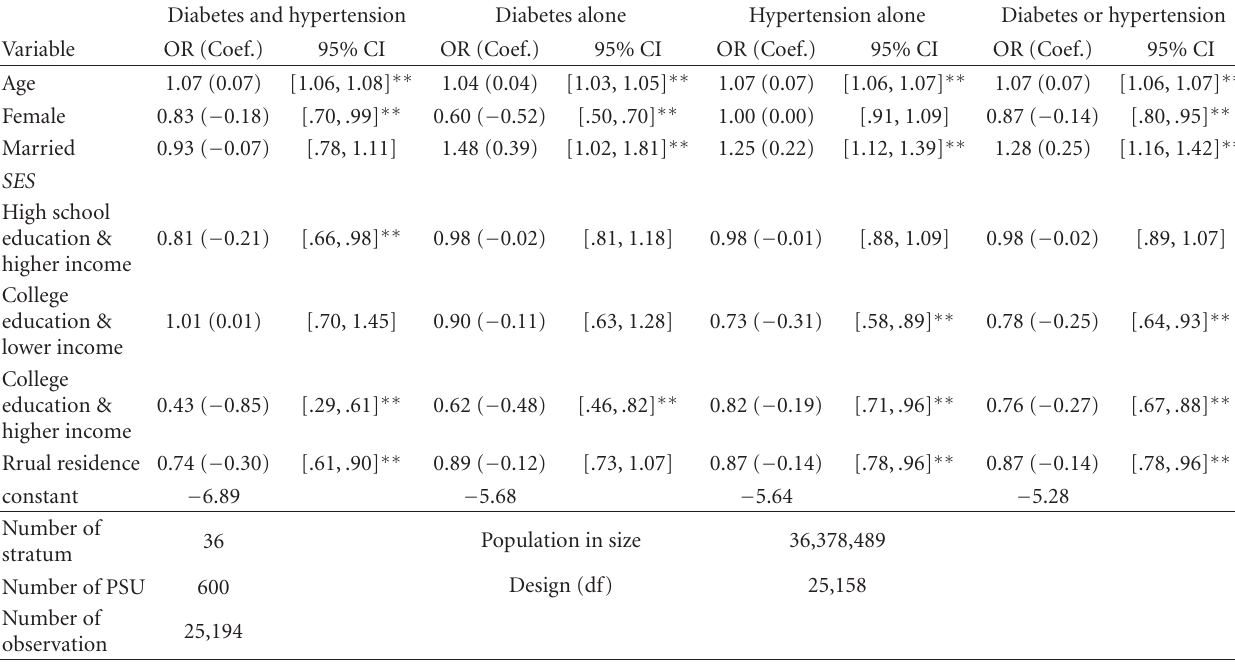
Table 2: The Results of Logistic Regression